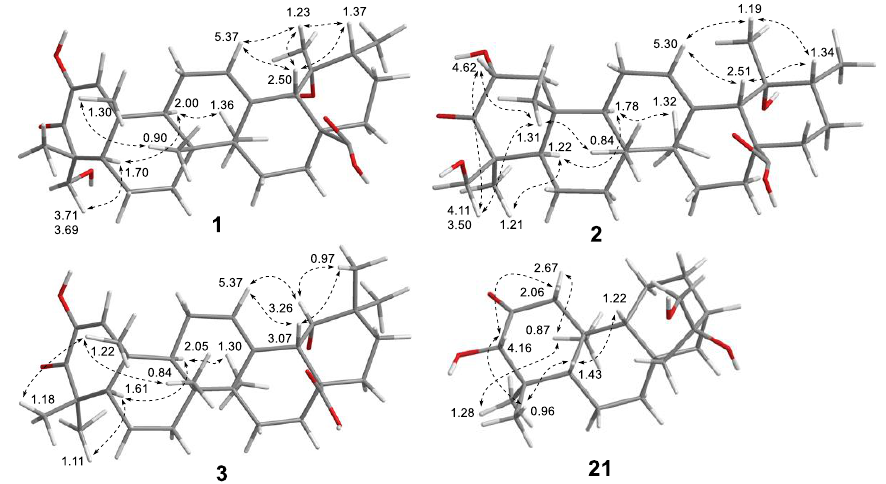
Figure 3. Observed key ROE correlations of compounds 1 − 3 and 21 .